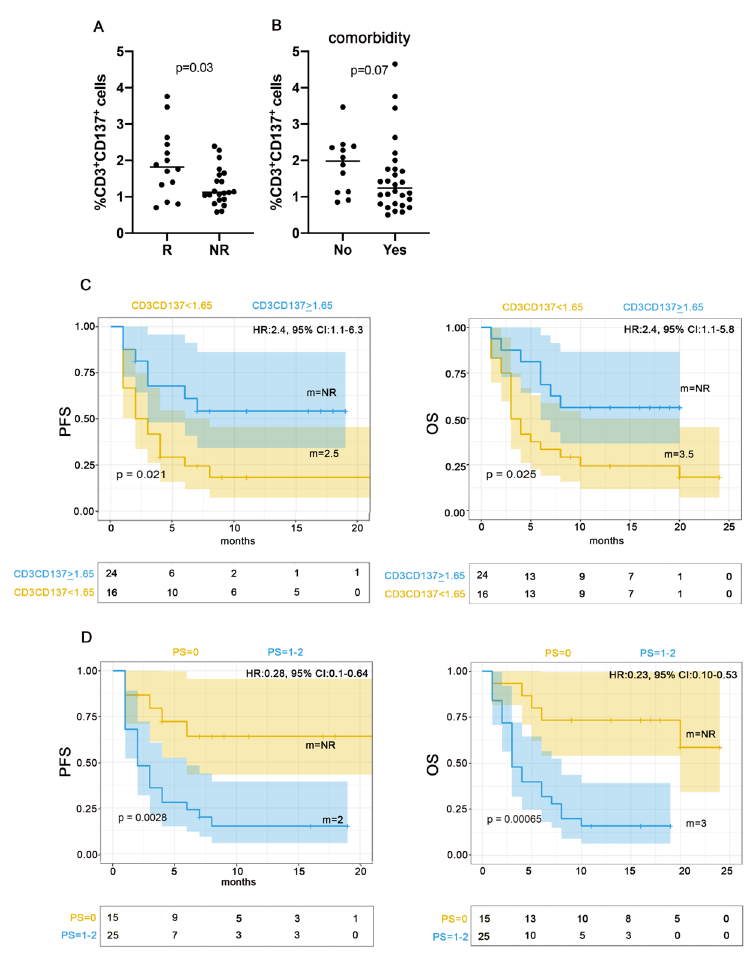
Figure 1. CD137 + T cells are correlated with response to anti–PD–1 treatment and patient survival. ( A ) The scattered dot plot shows the values of CD3 + CD137 + cells in responder (R) and non–responder (NR) patients ± standard deviation (SD). The horizontal lines correspond to the median values of CD3 + CD137 + lymphocytes of the two groups. ( B ) The scattered dot plot represents the values of CD3 + CD137 + cells in patients with (Yes) or without (No) comorbidities. The horizontal lines correspond to the median values of CD3 + CD137 + lymphocytes of the two groups. ( C ) Kaplan–Meier curves for PFS and OS were used to determine 1.65% as the cut-off of circulating CD3 + CD137 + cells wherein patients with a percentage ≥ 1.65% showed prolonged survival. ( D ) Kaplan–Meier curves for PFS and OS considering the score related to performance status (PS) (PS = 0 vs. PS1 = 1, 2). Patients with PS = 0 showed a longer PFS and OS than those with PS = 1, 2. m = Months; NR =